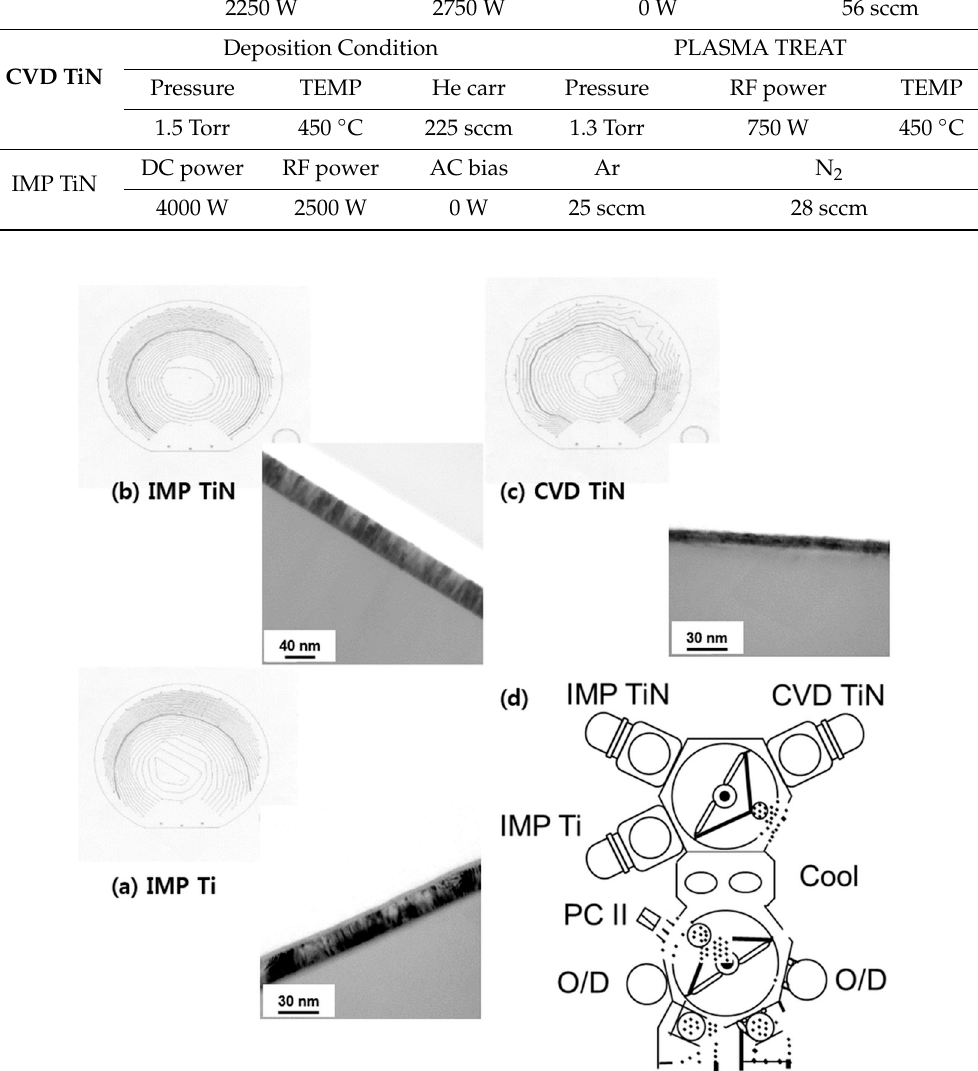
Figure 1. TEM image and Omnimap of ( a ) IMP Ti 200 Å, ( b ) IMP TiN 300 Å, and ( c ) CVD TiN 100 Å (2 × 50 Å). ( d ) Schematic diagram of cluster tool containing IMP TiN deposition chamber, IMP Ti deposition chamber, pre-clean chamber (PC II), cooling chamber, and CVD TiN deposition chamber.